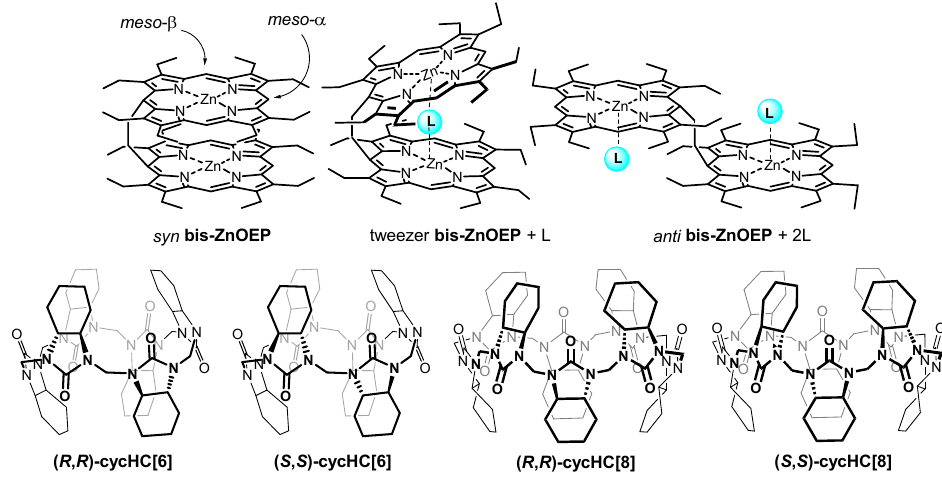
Figure 1. On top: structure of bis–ZnOEP in syn , tweezer, and anti conformations, and beneath: structures of ( R , R )- and ( S , S )- cycHC[ n ] .